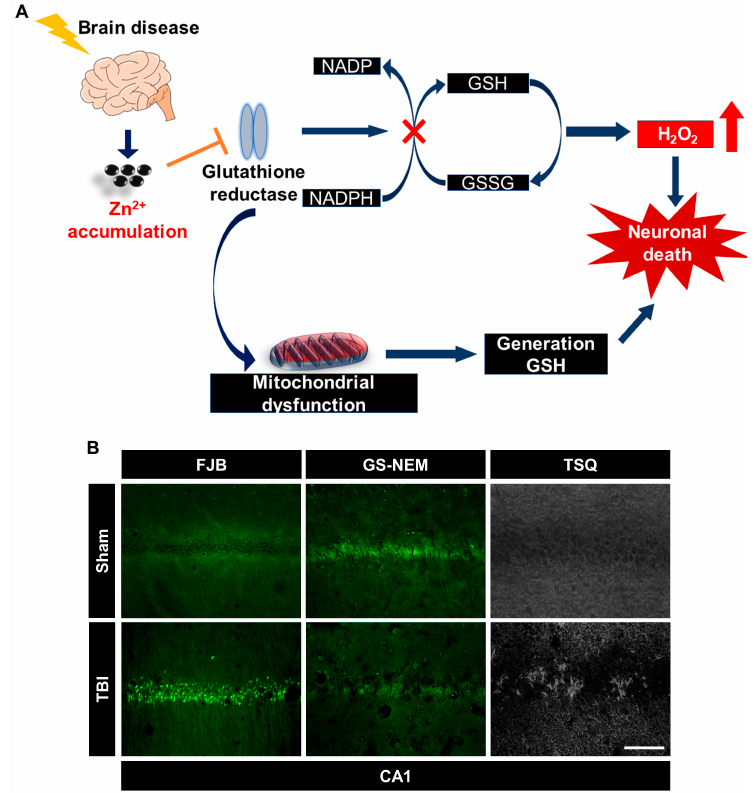
Figure 2. ( A ) Zinc inhibits glutathione reductase (GR) [60]. GR-mediated conversion of GSSG to GSH is inhibited by accumulated zinc [60]. Abnormal GR function leads to mitochondrial dysfunc- tion and disturbs GSH synthesis [59]. Depletion of GSH inhibits GR activity following zinc overload and induces neuronal damage [56]. ( B ) Immunofluorescence images show degenerating neurons in the hippocampal CA1 region 24 h after traumatic brain injury (TBI), detected using Fluoro-Jade B (FJB, green color); immunofluorescence images show degenerating neurons detected using a gluta- thione antibody, N-ethylmaleimide adduct (GS-NEM, green color), in the hippocampal CA1 region 24 h after TBI; zinc-specific representative fluorescence image displays TSQ (+) neurons by N-(6- methoxy-8-quinolyl)-para-toluene sulfonamide (TSQ) in the hippocampal CA1 region 24 h after TBI. Scale bar = 100 μ m. To enhance neuronal GSH concentrations, several studies have evaluated the chela- tion of synaptically released zinc using a thiol-containing chemical compound, N-acetyl-